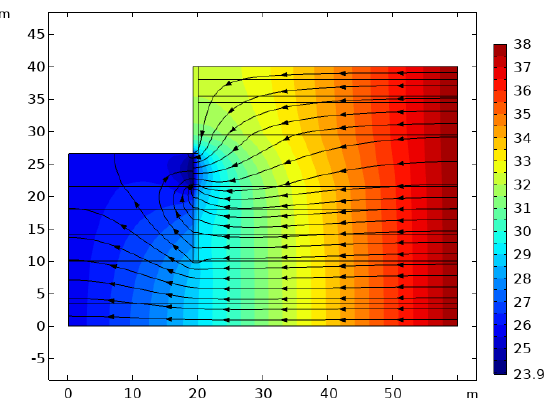
Figure 15. Flow network diagram with permeability coefficient of 5 × 10 -1 m·d -1 .